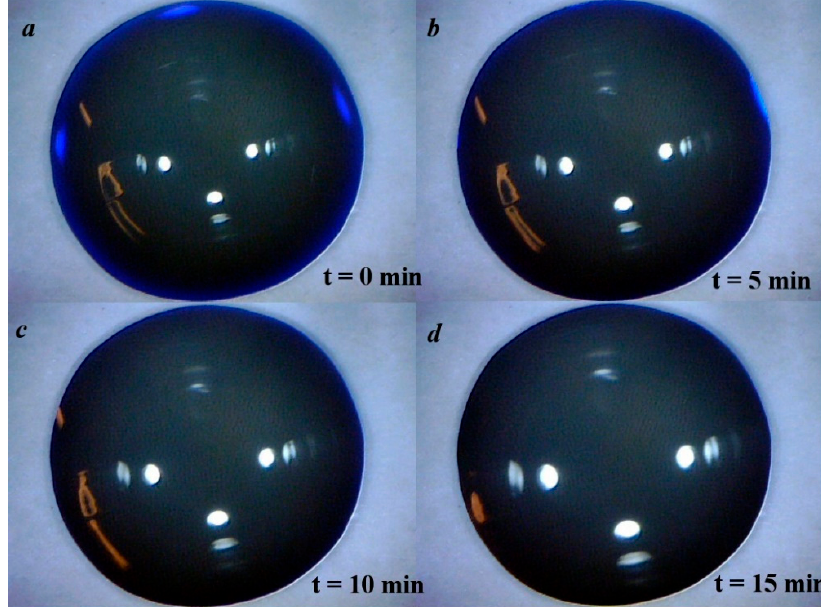
Figure 5. A spherical cap photographed at different time intervals ( a – d ), after its deposition on the substrate Although evaporation occurs during time, reducing the volume and curvature of the droplet (as it could be seen by the different position of the light reflexes on the drop surface), the diameter of it remain the same for a time-lapse sufficient to capture the image. All the pictures were acquired at different times on the same droplet with the same focus and field of view (reduced by cropping to approx. 6 mm).